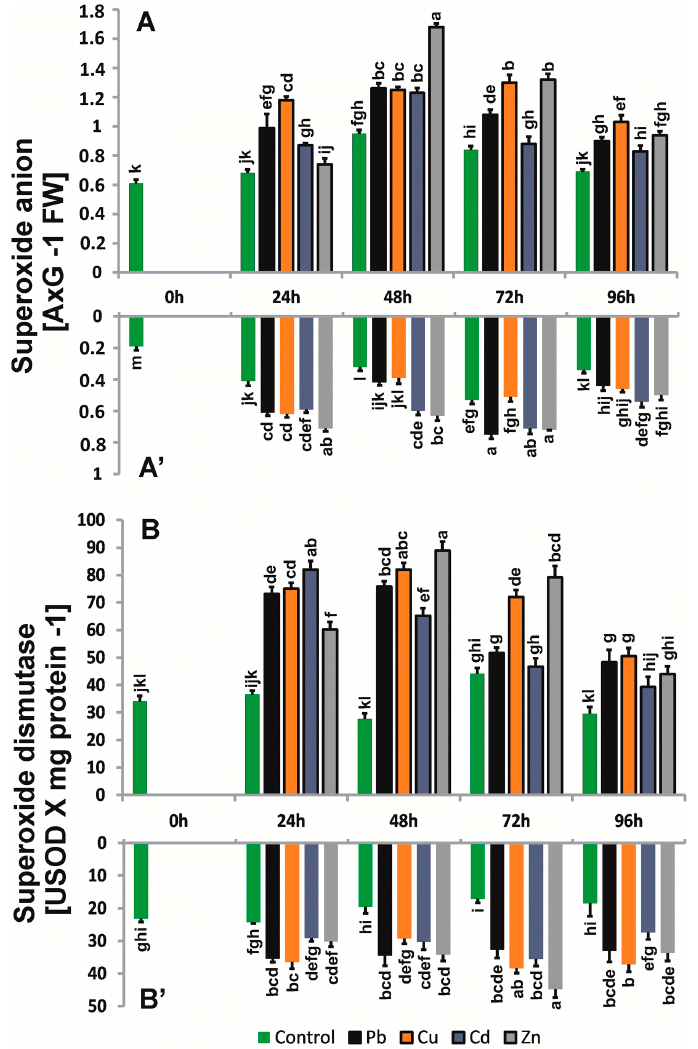
Figure 3. Superoxide anion (A580 g − 1 FW) level and SOD (USOD mg -1 protein) activities in roots and above-ground parts of B. juncea var. Malopolska seedlings grown in Hoagland’s medium and treated with lead, cooper, cadmium, and zinc ions. Metal solutions Pb(NO 3 ) 2 , CuSO 4 , CdCl 2 , and ZnSO 4 were applied at a 50 μ M concentration. Mean values of three replicates (±SD).